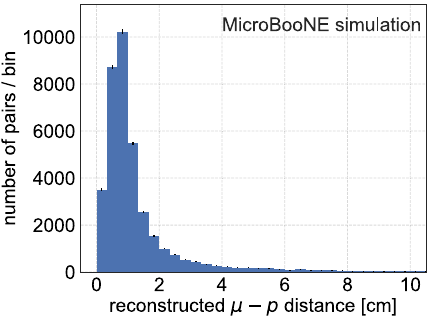
Fig. 2 The reconstructed distance between the start point of the muon and the proton tracks in simulated CC1 p 0 π events in MicroBooNE. The error bars are statistical only